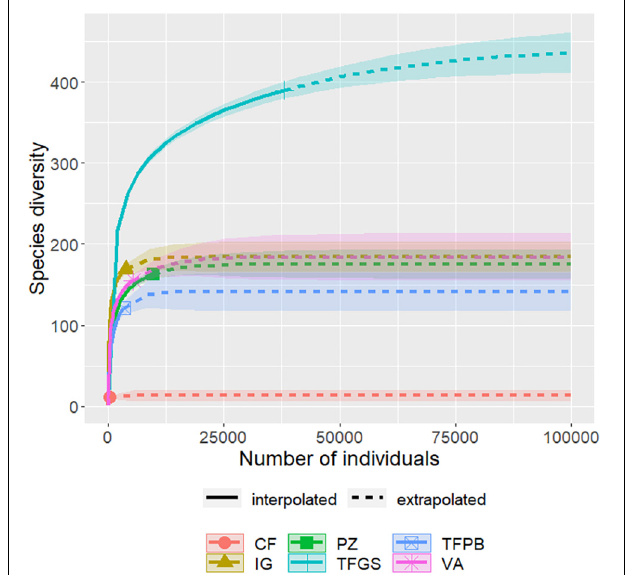
FIGURE 2 | Rarefaction and extrapolation curves for the six environments sampled in the Amazon. Colors represent environments. Dotted lines represent the richness found and shaded lines represent the extrapolation of species